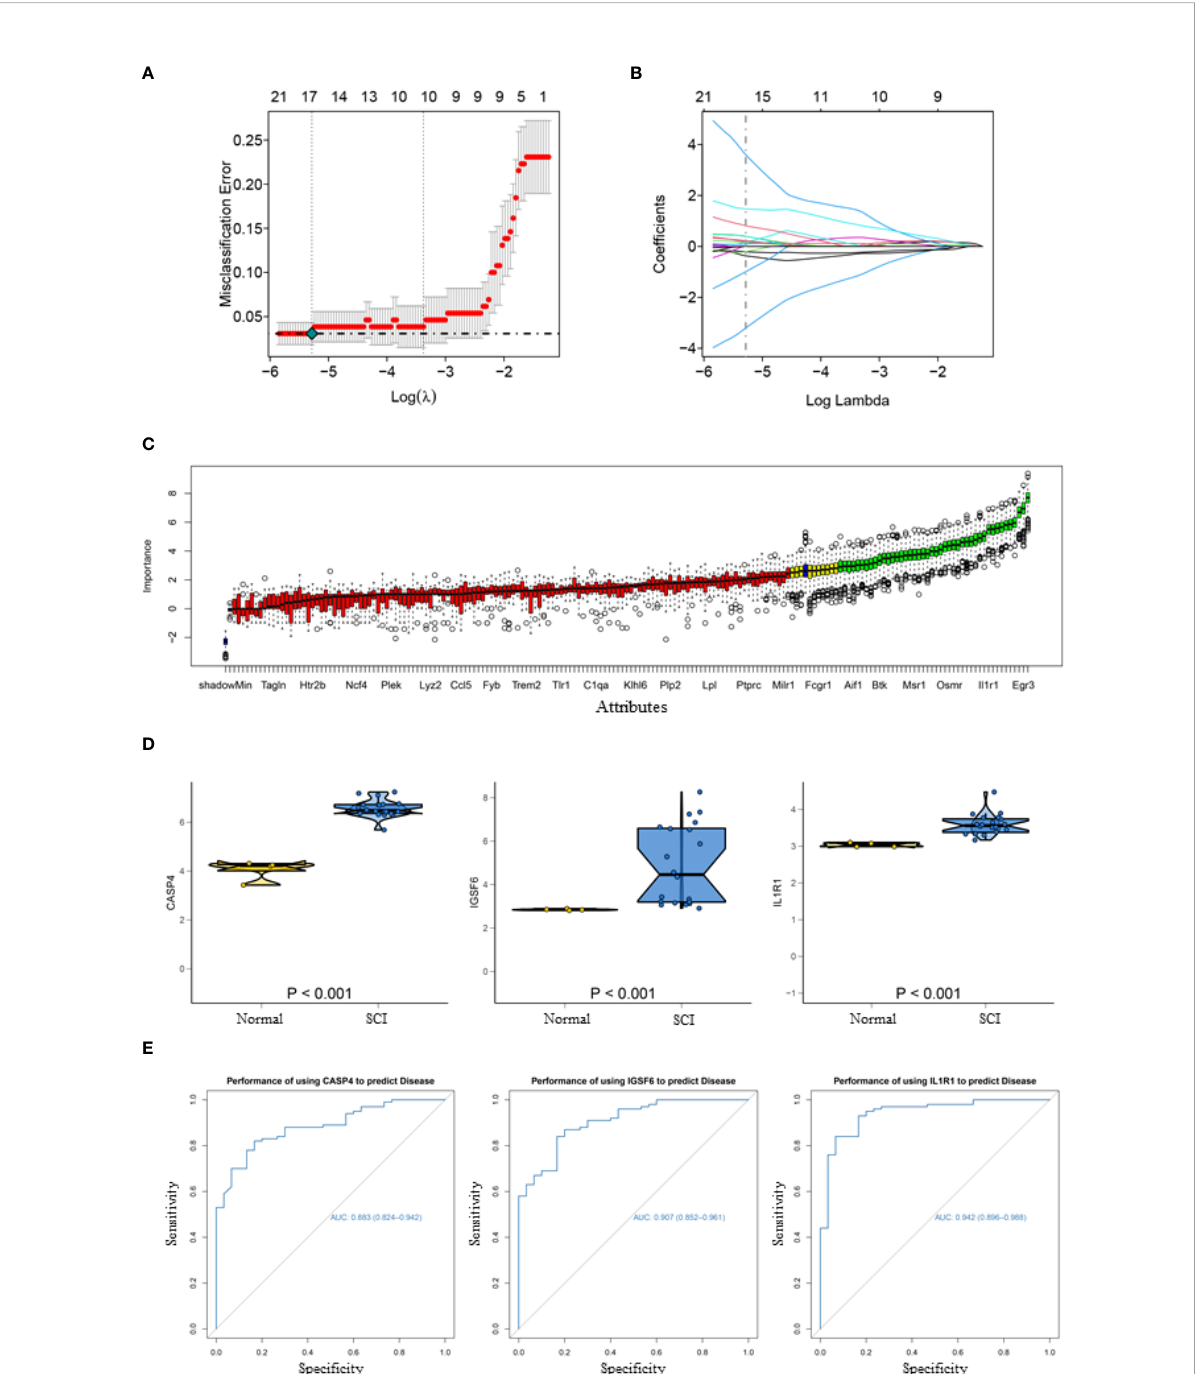
FIGURE 2 Acquisition and validation of candidate diagnostic markers. (A) LASSO regression showed the binomial deviation of different quantitative variables. The lower horizontal coordinate indicates the value of the lasso regression model parameter l , the upper horizontal coordinate indicates the number of coef fi cients in the corresponding model, and the vertical coordinate indicates the error of the model. There are two dashed lines, the line with the lowest error on the left and the line with fewer features on the right. (B) Coef fi cient of LASSO regression model. As the l value changes, the later the coef fi cient is compressed to zero the more important the variable is. (C) Boruta algorithm to screen diagnostic biomarkers. (D) Box violin maps of CASP4, IGSF6 and IL1R1 indicate that the differential expression in SCI group was signi fi cantly different from that in the normal group. (E) The ROC curves of the diagnostic ef fi cacy of CASP4 (AUC=0.883), IGSF6 (AUC=0.907) and IL1R1 (AUC=0.942), the area under which was used to evaluate the